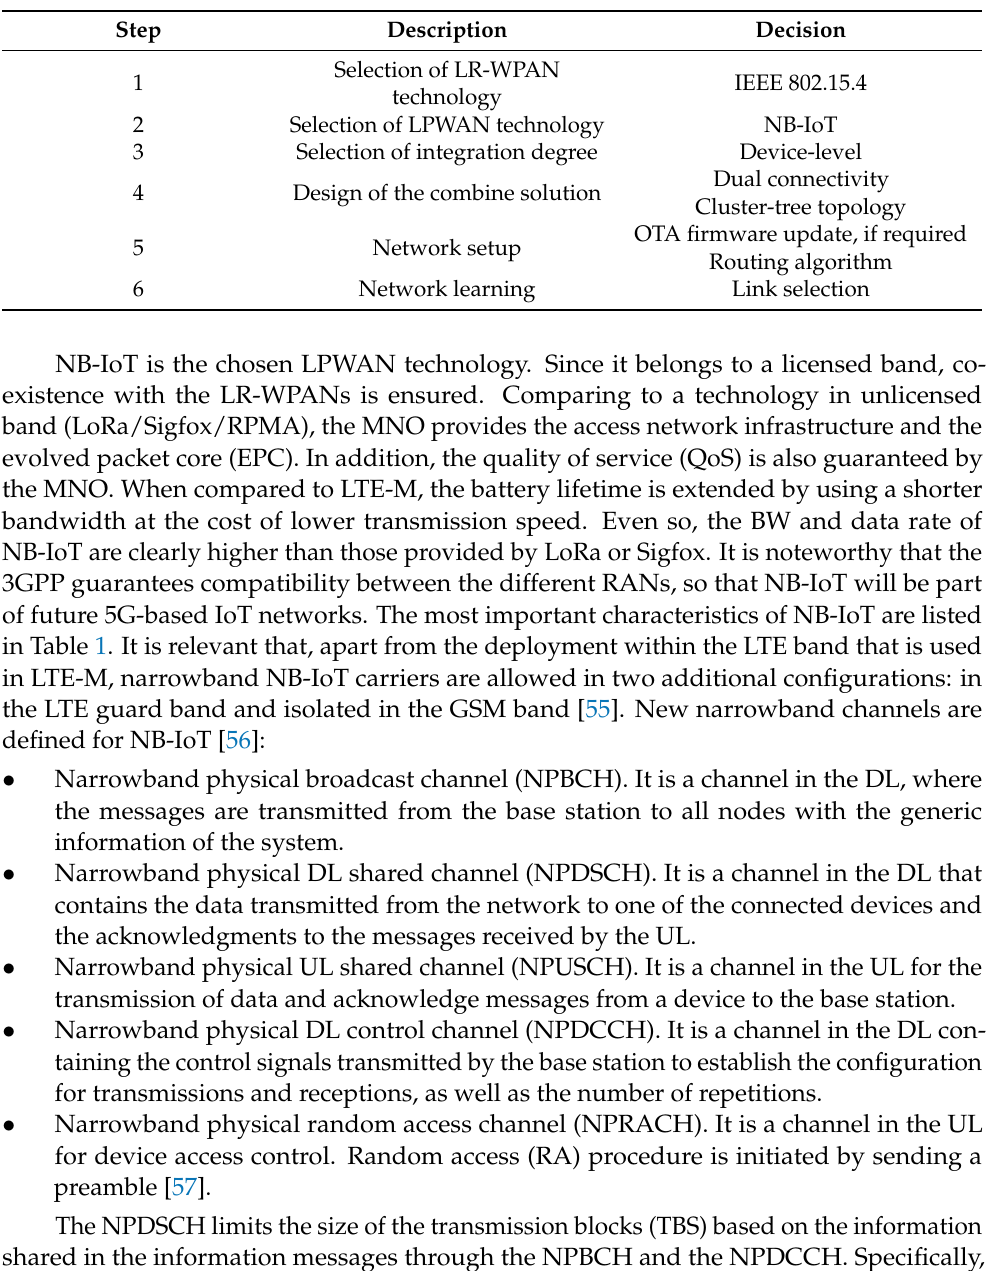
Table 4. Decision-making in the combined network design